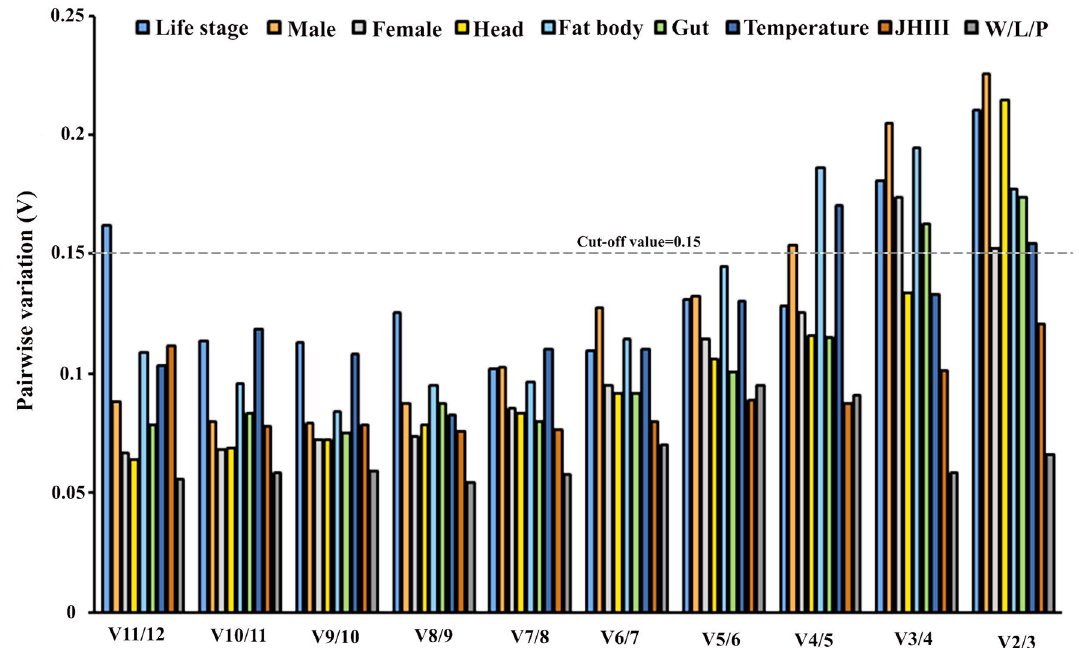
fat body, temperature; Juvenile hormone III; wild-collected vs long-term laboratory-reared beetles]. Based on geNorm analysis, average pairwise variations were calculated between the normalization factors NFn and NFn + 1. Values < 0.15 imply that n + 1 genes were unnecessary to normalise gene